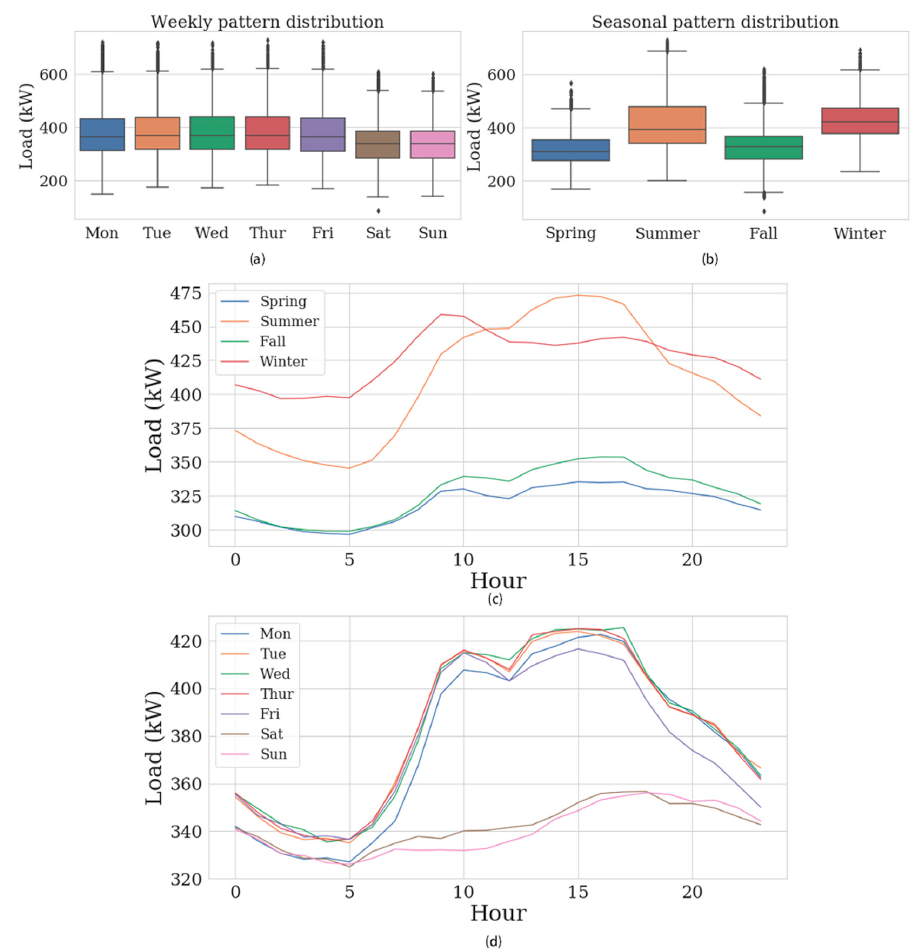
Figure 1. Box plot of load patterns according to the ( a ) season and ( b ) the day of the week. Line plot of load patterns according to the ( c ) season and ( d ) the day of the week. load patterns according to the ( c ) season and ( d ) the day of the